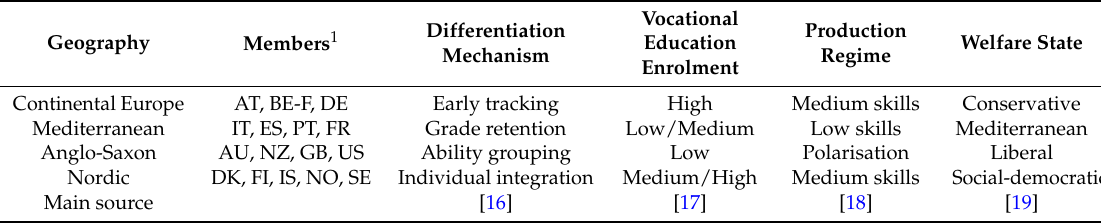
Table 1. Typology of educational